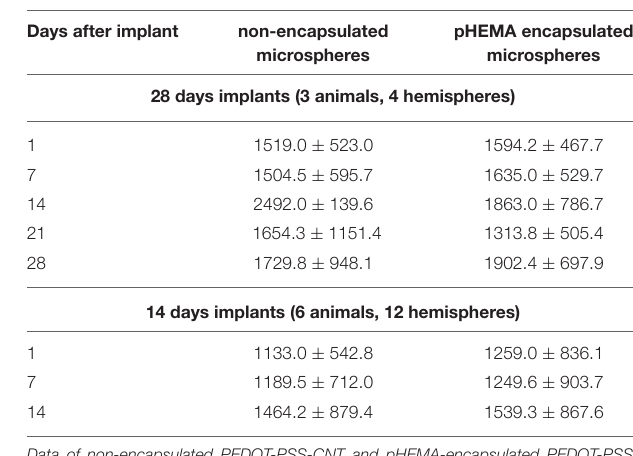
TABLE 3 | Spikes/min (average ± SD) recorded from 3 animals (4 hemispheres) at 1, 7, 14, 21, and 28 days after implant, and from 6 animals (12 hemispheres) at 1, 7, and 14 days after